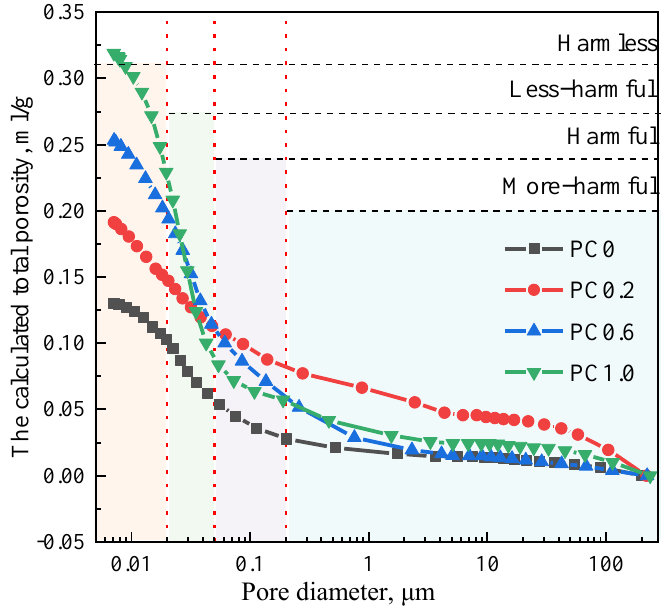
Figure 3. Pore size distribution curves of various cement specimens. Table 2. The porosity in different pore size intervals of the cement specimens (mL/g).